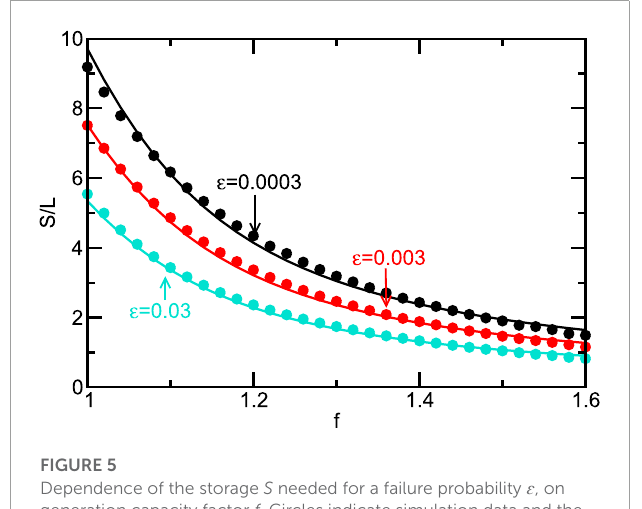
FIGURE 5 Dependence of the storage S needed for a failure probability ɛ , on generation capacity factor f . Circles indicate simulation data and the curves give the theoretical result of Eq. 12 . L is the daily load.